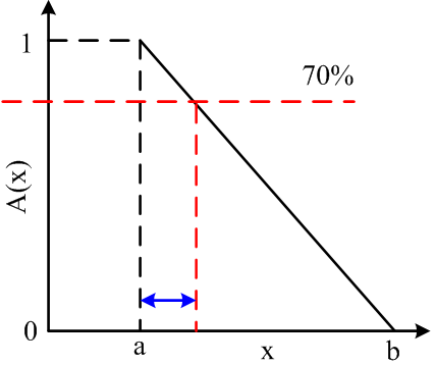
Figure 13. Partially small membership function .